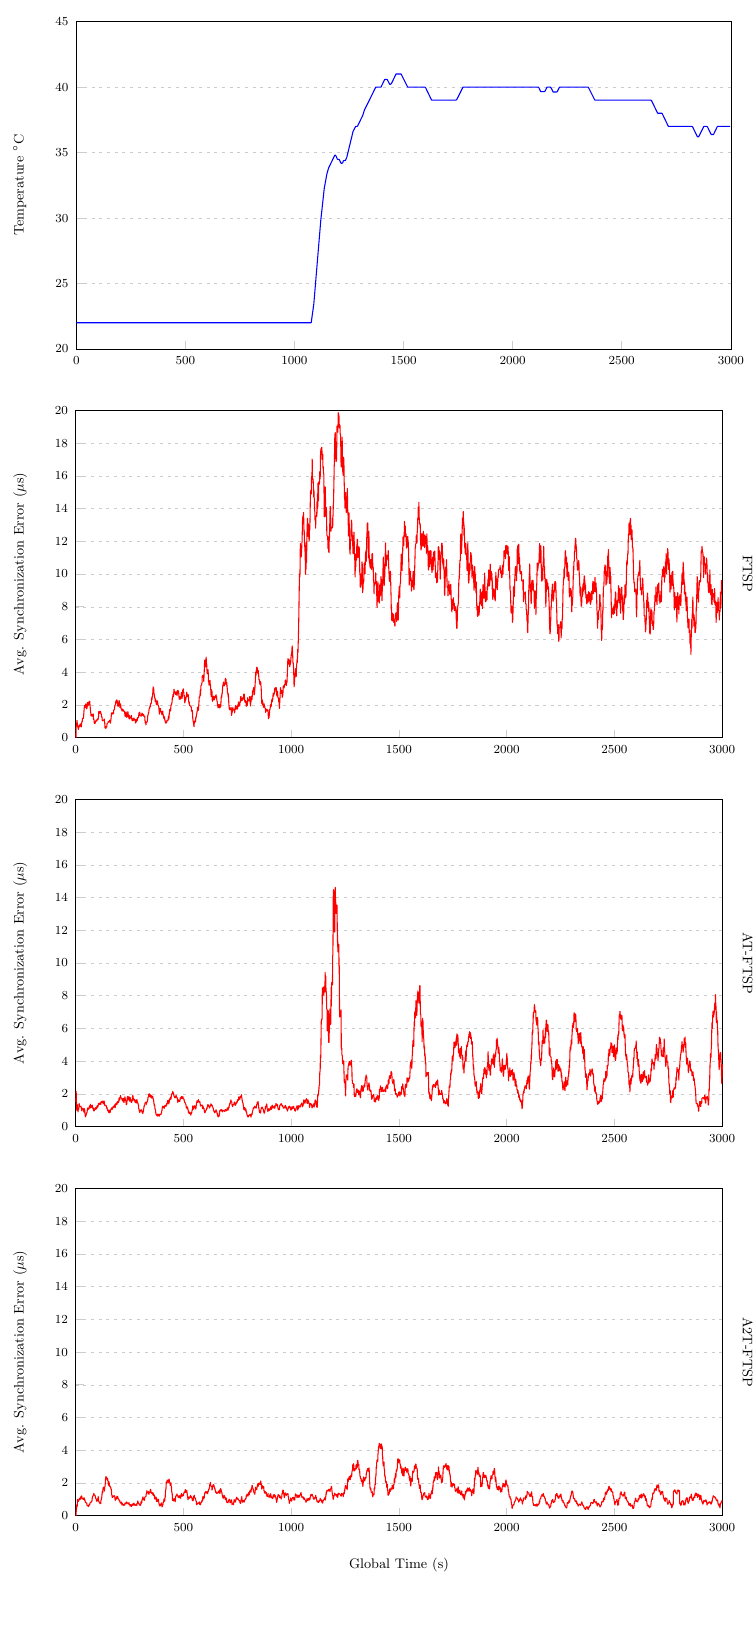
Figure 7. High temperature